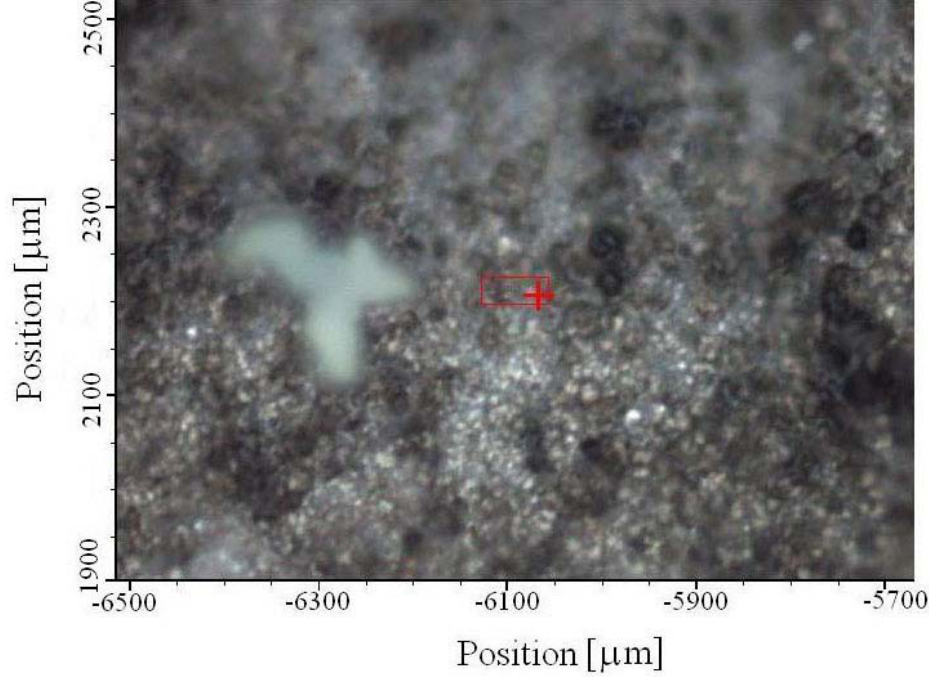
Figure 3. Micro-Raman image of oxidation coating with mapping